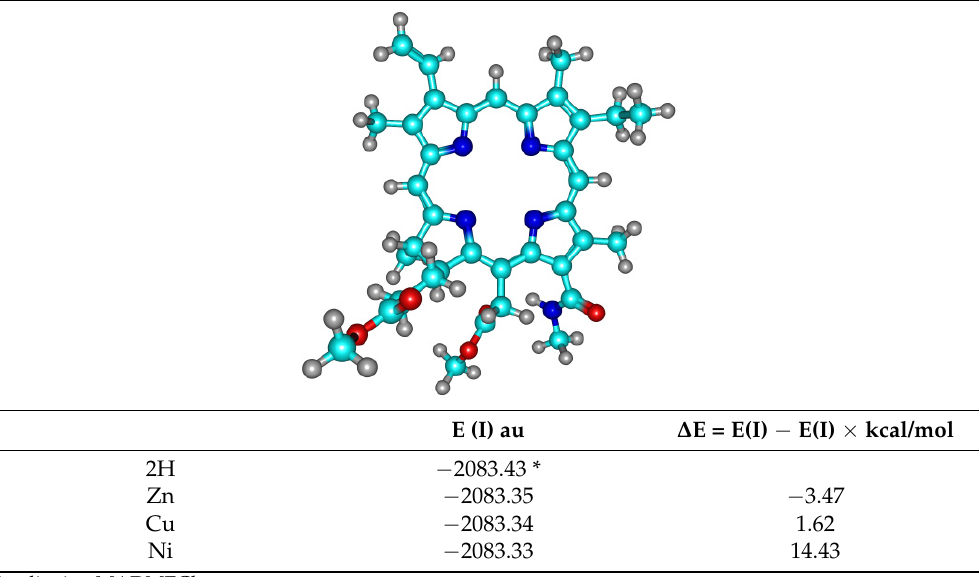
Table 5. Spectral parameters of macroheterocycles in chloroform